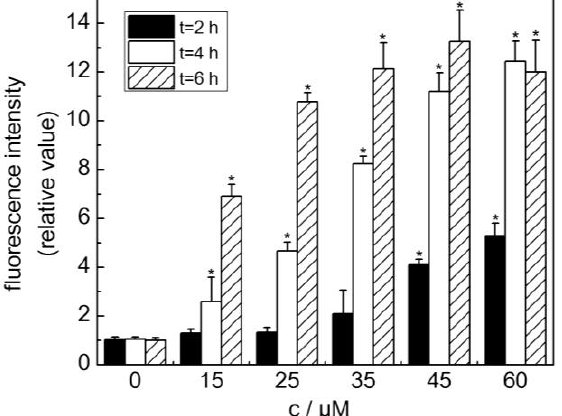
Figure 5. Quantification of GFP fluorescence following exposure of sensor cells to CdCl The responses of sensor cells to treatments with 15, 25, 35, 45 and 60 µM CdCl and 6 h were analyzed by quantitative fluorescence microscopy. Relative fluorescence intensity relates to the corresponding values for samples from the untreated cells, which was set as 1 [mean ± SE; n = 3; *P < 0.05].